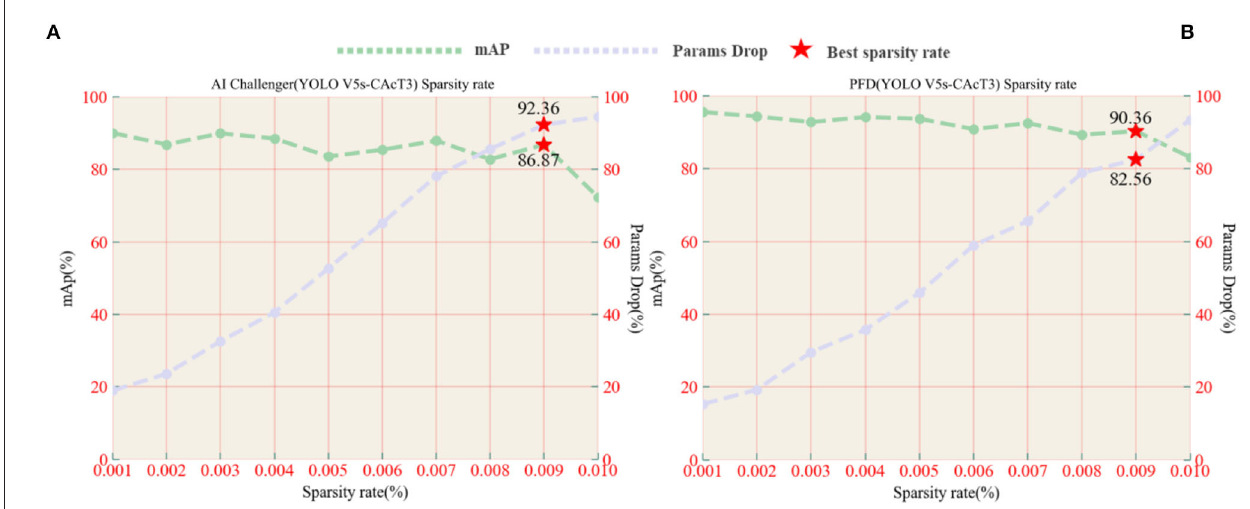
FIGURE 10 | (A) AI Challenger accuracy, parameter drop, and sparsity curves vs. (B) PFD accuracy, parameter drop, and sparsity curves.